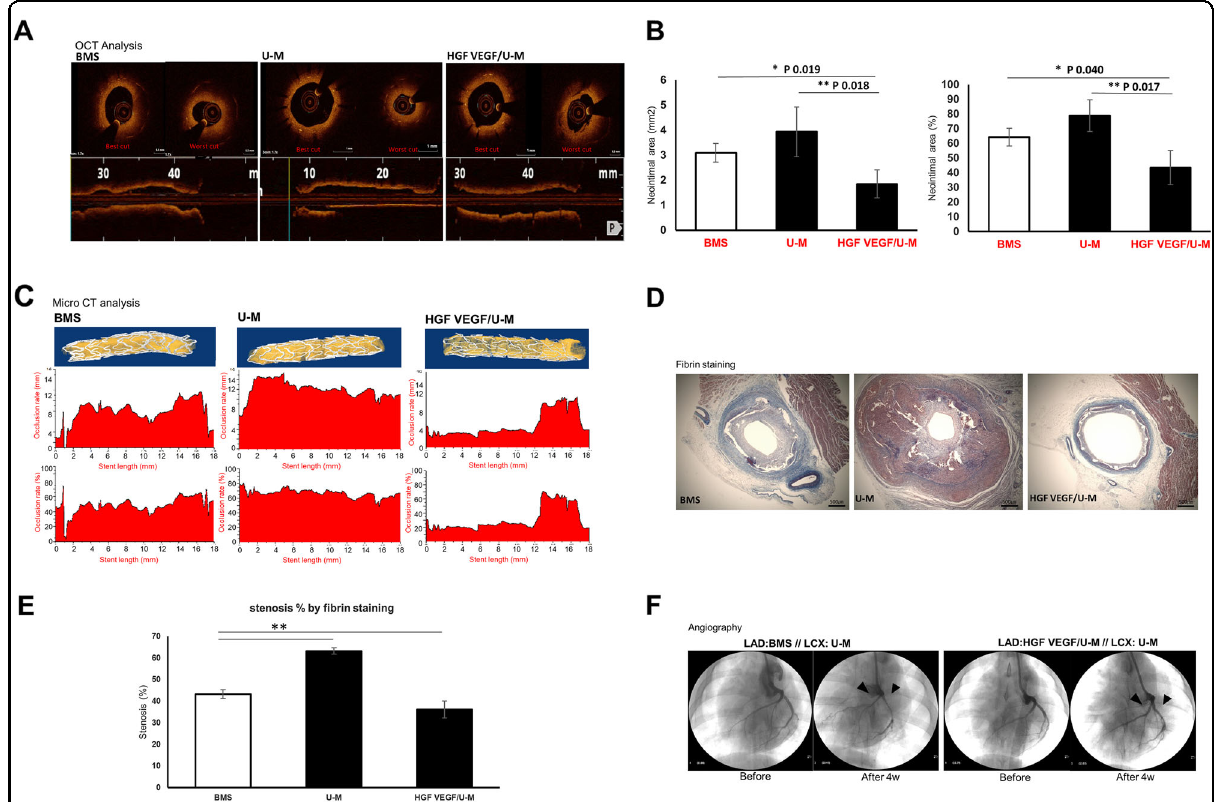
Fig. 5 Stents coated with HGF + VEGF/U-Ms reduced the neointimal area 4 weeks after transplantation. a OCT results showing the neointima degree in the lumens of the coronary arteries 4 weeks after transplantation. b The neointima degree was analyzed in mm 2 and the % of the neointima area (*; p -value of 0.019 and 0.040, **; p -value of 0.018 and 0.017). c Representative microCT images of the stents 4 weeks after transplantation. d Image of fi brin staining showing the fi brotic area with a cross-section of the transplanted stents. e The stenosis degrees were assessed as the % of fi brin staining (** p -value of 0.01). f Angiography showing the blood fl ow in the coronary artery with the transplanted stent. BMS; N = 6, U-M; N = 6, HV/U-M; N =